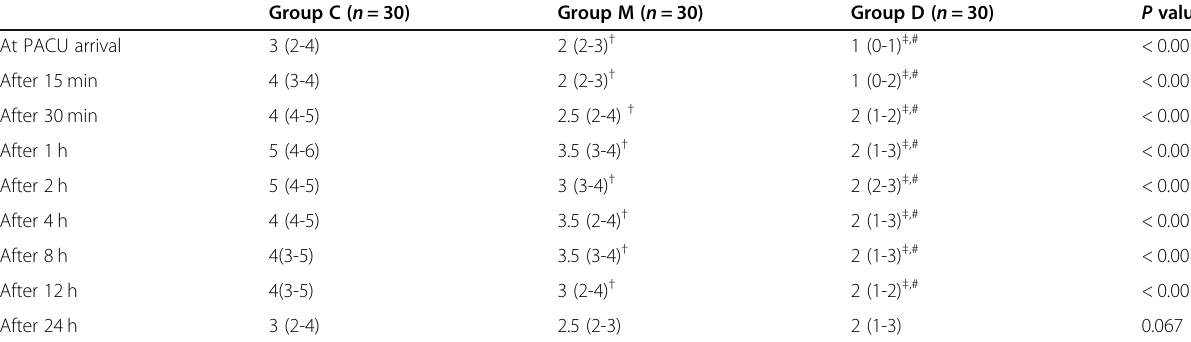
Table 8 Postoperative VAS recordings expressed as median (interquartile range)